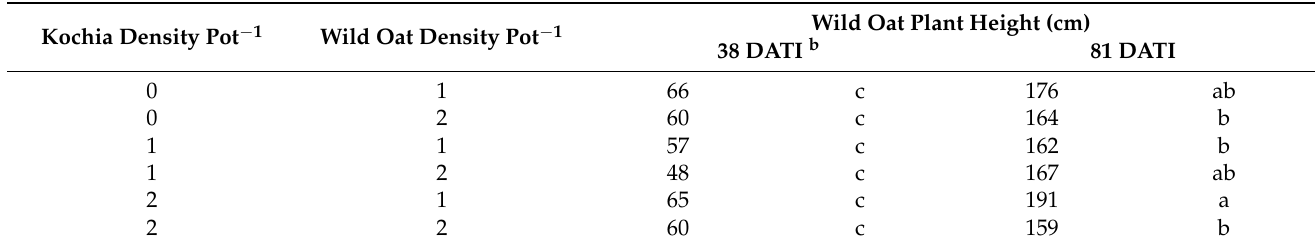
Table 2. Wild oat ( Avena fatua ) plant heights for the second experimental run as impacted by kochia ( Kochia scoparia ) density, wild oat density, and measurement timing when grown in a greenhouse in Saskatoon, SK in 2019 to 2020 a . Kochia Density Pot −